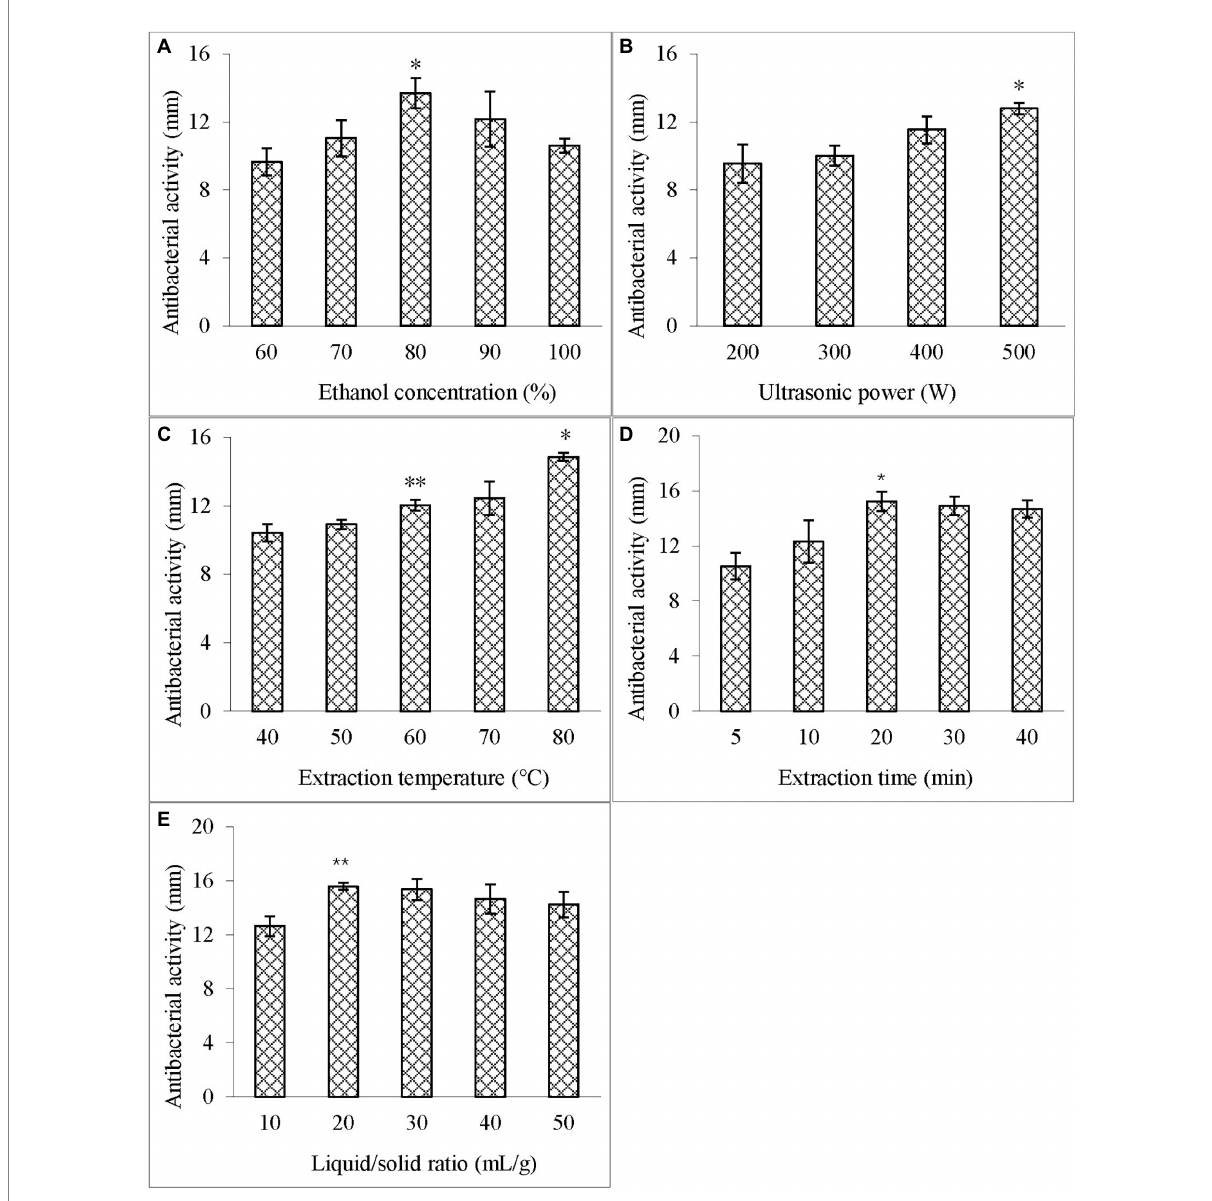
FIGURE 1 Effects of different single factors on the diameter of the inhibition zone of the extract. (A) Ethanol concentration; (B) Ultrasonic power; (C) Extraction temperature; (D) Extraction time; and (E) Liquid–solid ratio. Compared with the previous column, an asterisk (*) represents p < 0.05 and the double asterisk ( ** ) represents p <